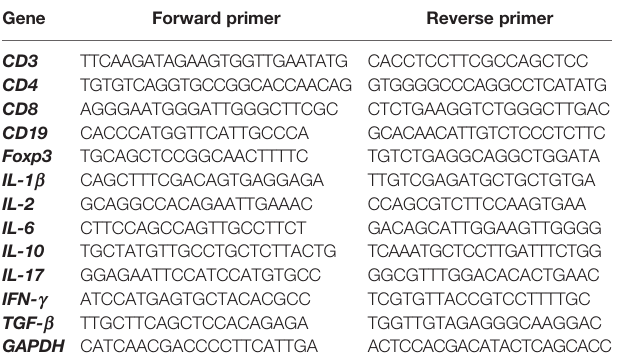
TABLE 1 | List of primers used for